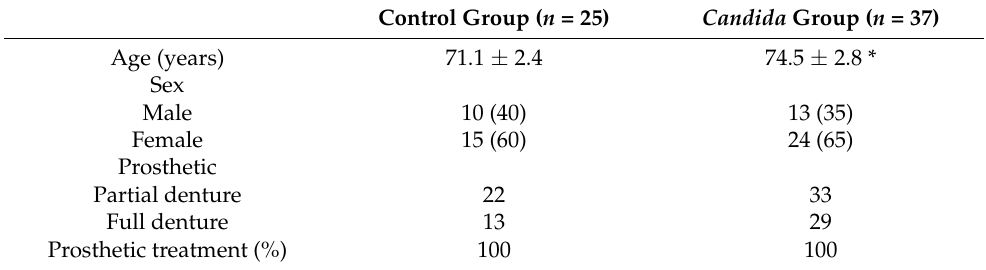
Table 1. Participant characteristics.